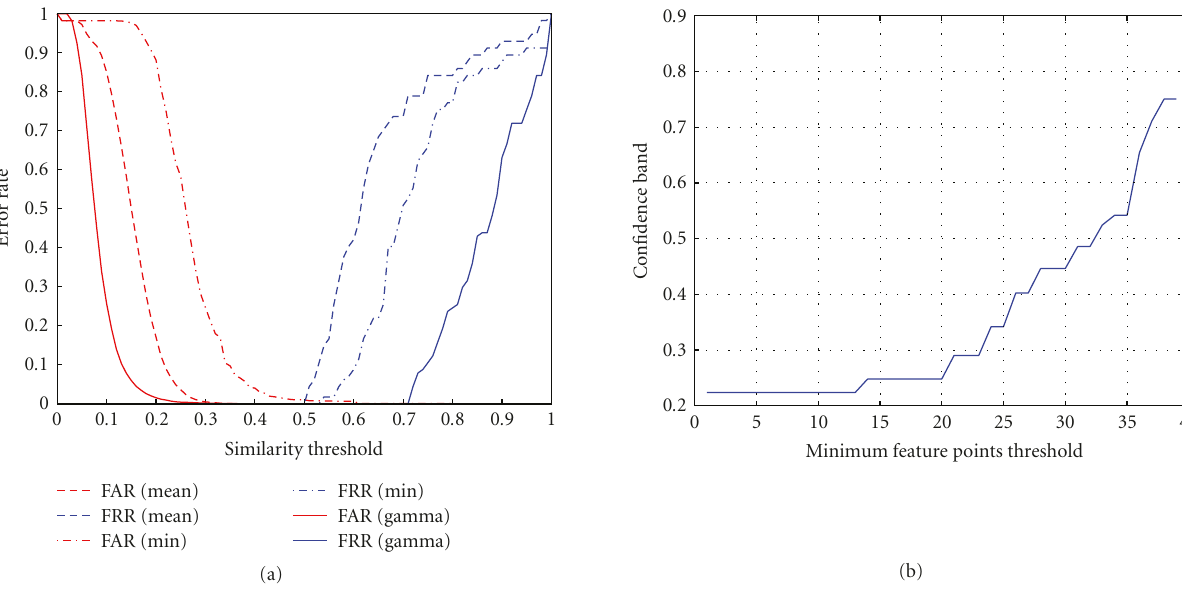
Figure 16: (a) FAR and FRR curves for the normalised similarity metrics (min: normalised by minimum points, mean: normalised by geometrical mean, and gamma: gamma corrected metric). The best confidence band is the one belonging to the gamma corrected metric corresponding to 0 . 2337.(b) Evolution of the confidence band using a threshold of minimum detected points per